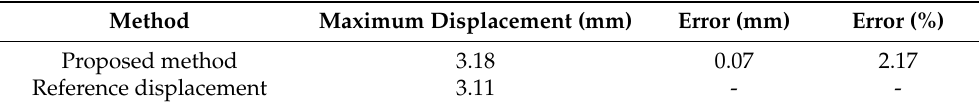
Figure 9. Comparison of structural displacements at the mid-span point of the Keukrak Bridge. Table 3. Comparison of displacement measurements on the Keukrak Bridge . Table 3. Comparison of displacement measurements on the Keukrak Bridge.